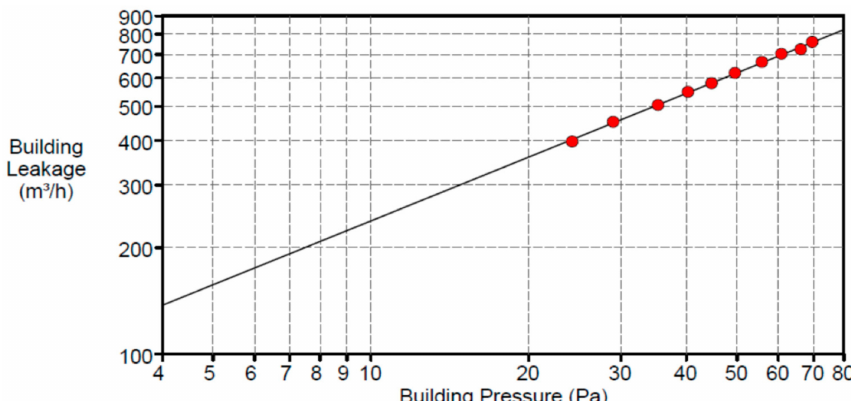
Figure 6. Dwelling envelope airtightness test before refurbishment.